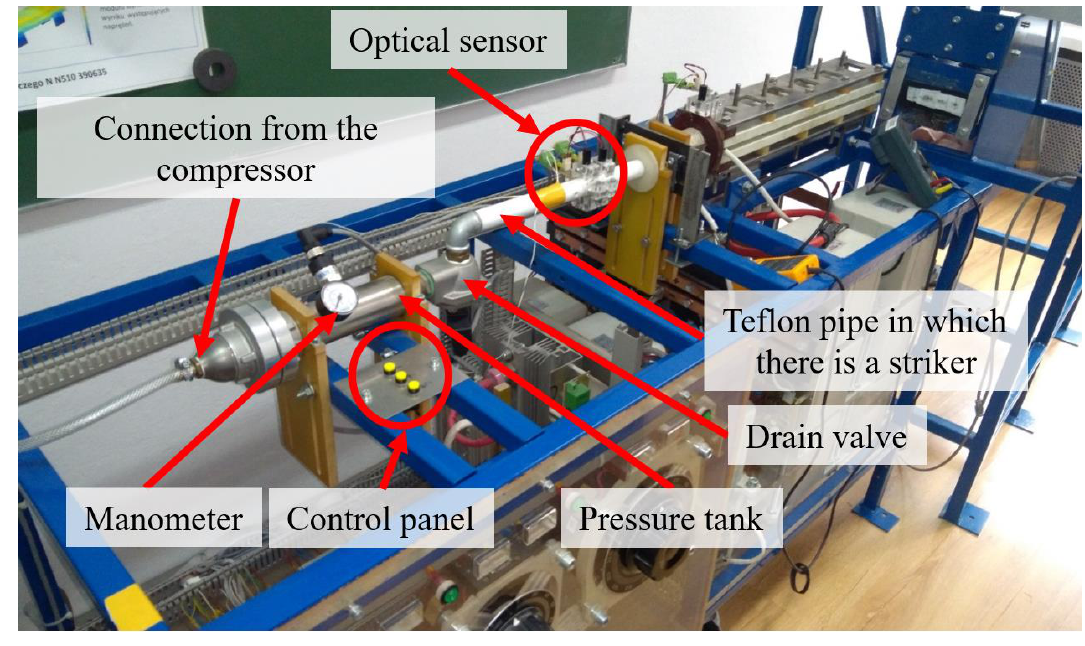
Figure 3. Test stand used in experiment.